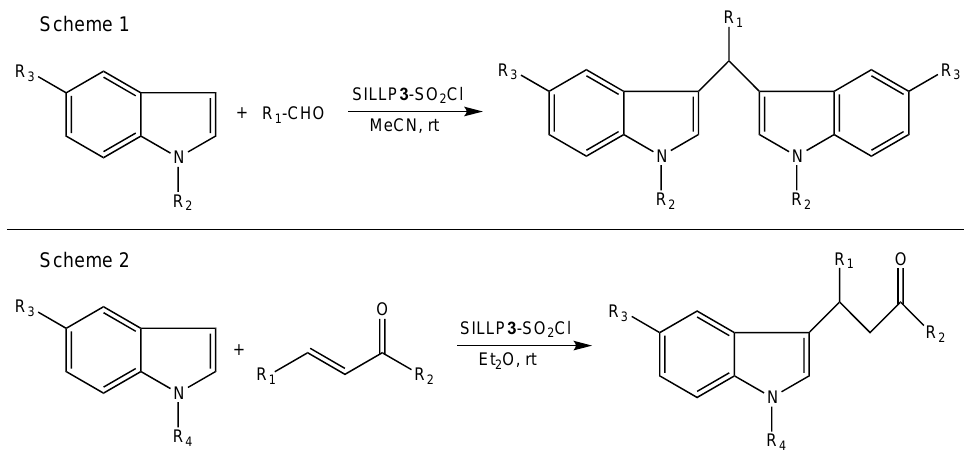
Figure 7. Applications of Lewis type SILLP material 3 in the synthesis of bis(indolyl)methanes (Scheme 1) and addition of indole to vinyl ketones (Scheme 2).